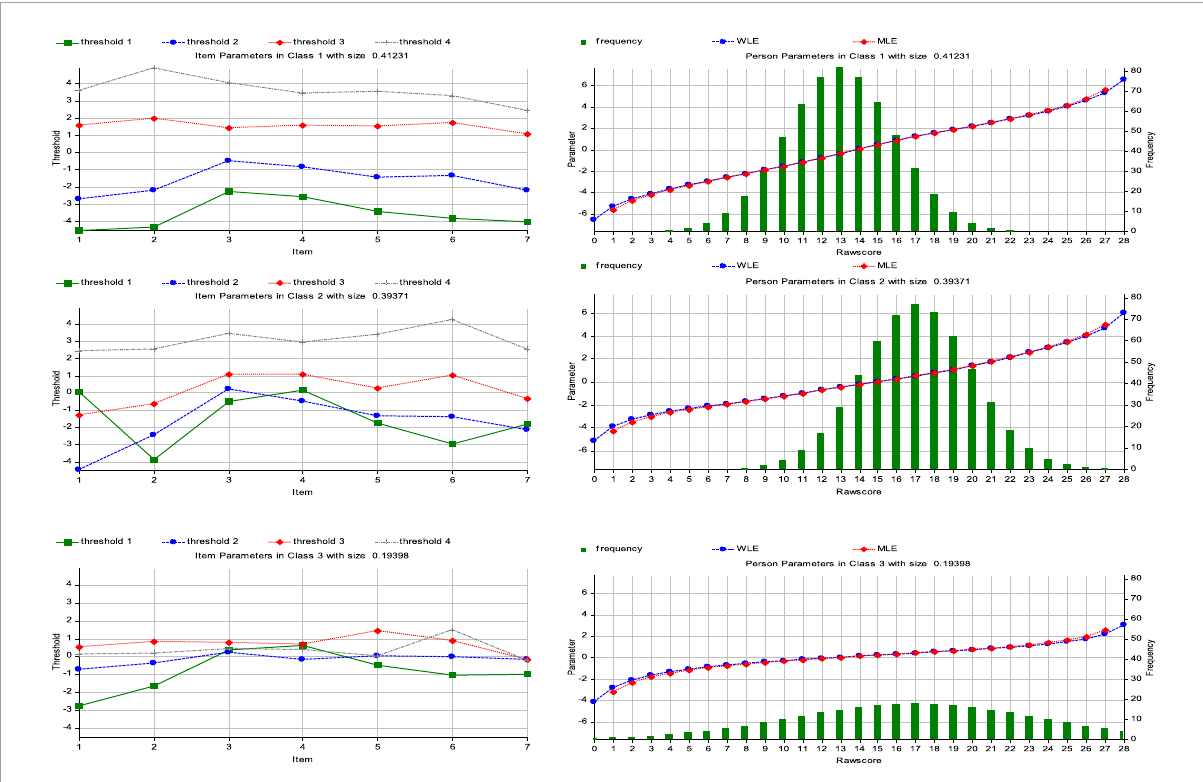
FIGURE1 Item Parameters and Person Parameters – Partial Credit Model. The Item Parameter graph shows the threshold for each one of the seven items of the IOS. The Person Parameter graph show the absolute raw score frequencies for each one of the three class solutions.